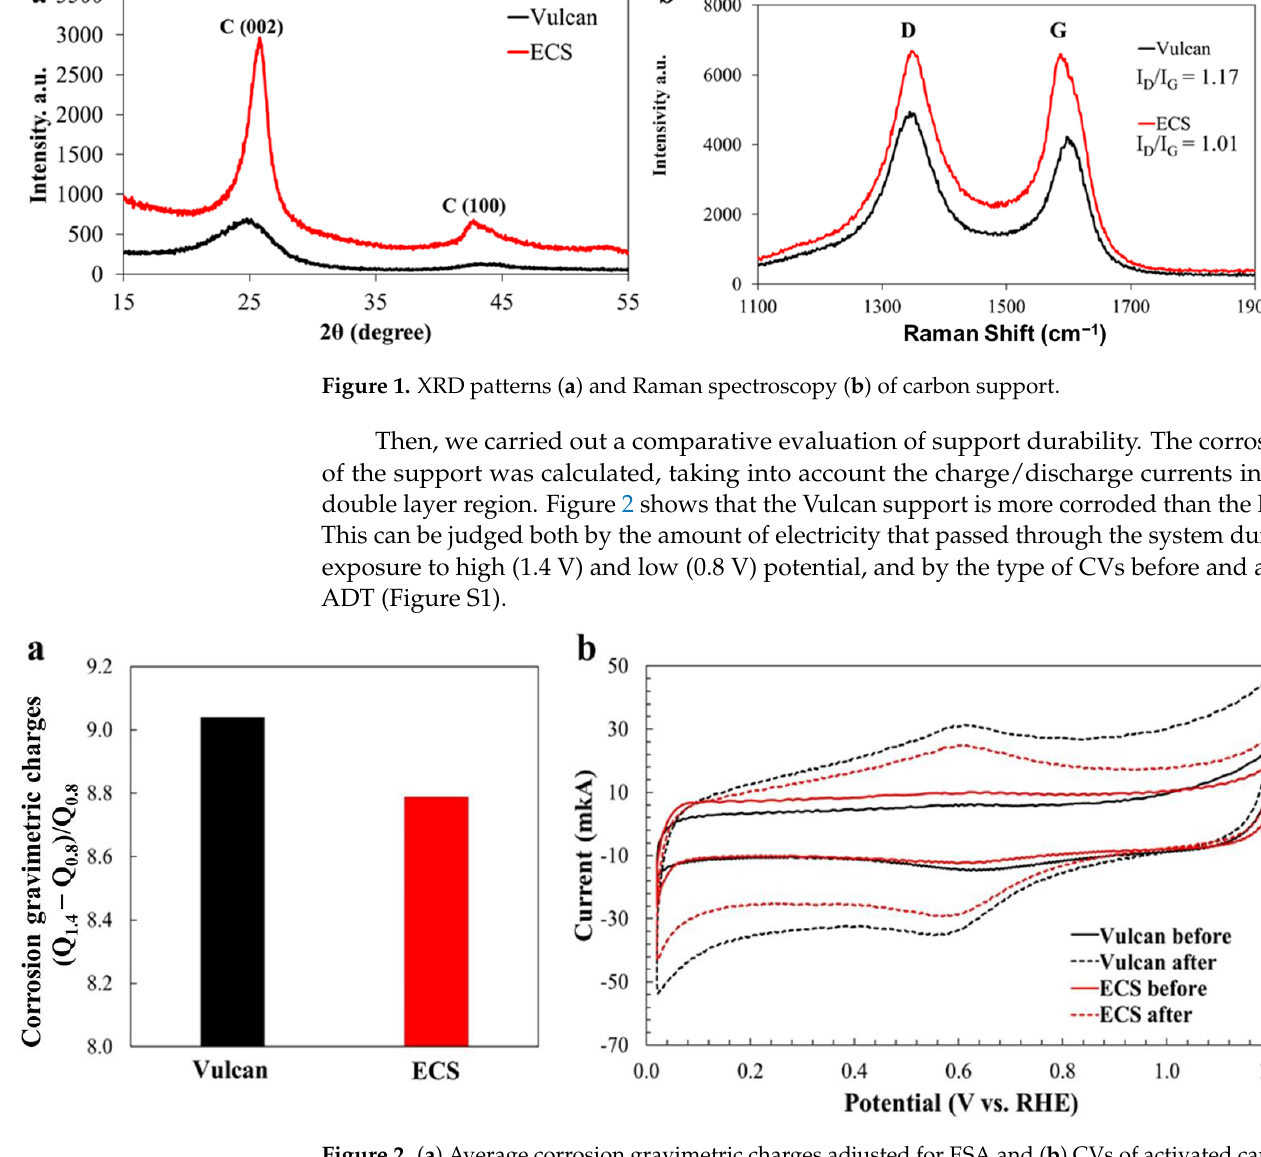
Figure 2. ( a ) Average corrosion gravimetric charges adjusted for ESA and ( b ) CVs of activated carbon support before and after ADT. Electrolyte is 0.1 M HClO 4 , atmosphere of Ar, and T = 60 °C.